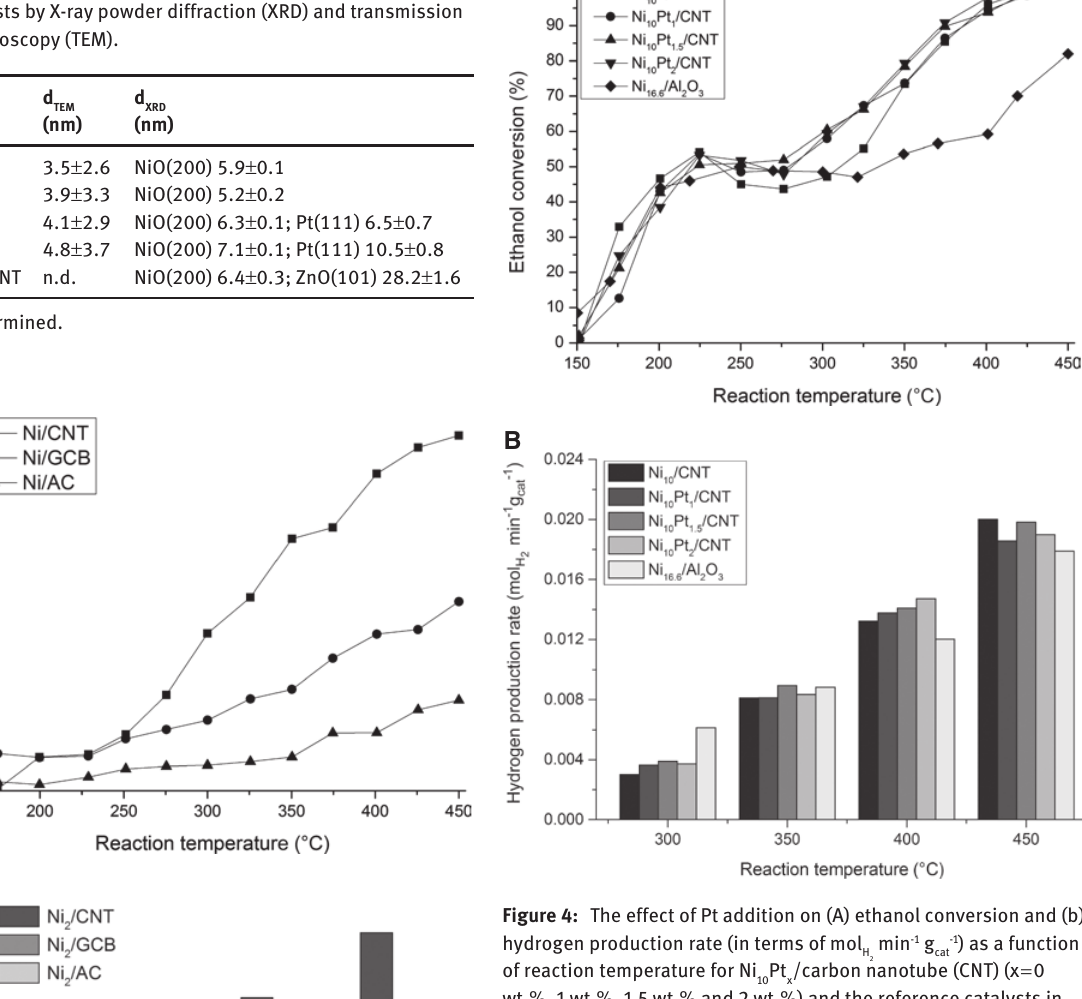
min -1 g cat-1 ) as a function H 2 Pt /carbon nanotube (CNT) (x = 0 10 x